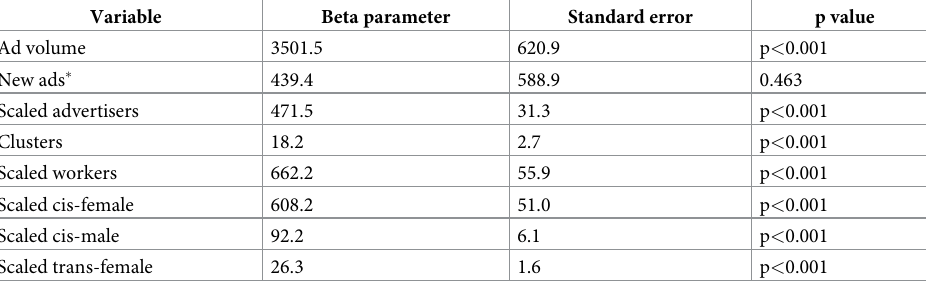
Table 3. Changes by month from start of data collection for